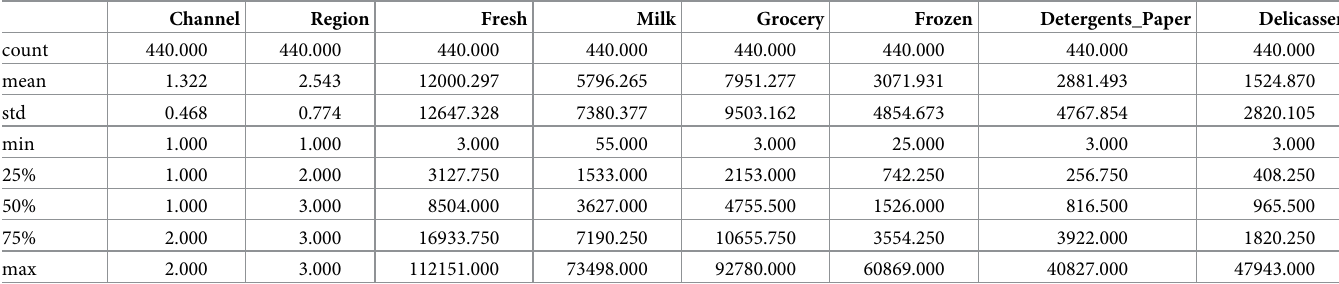
Table 4. Summary statistics of wholesale customers data.